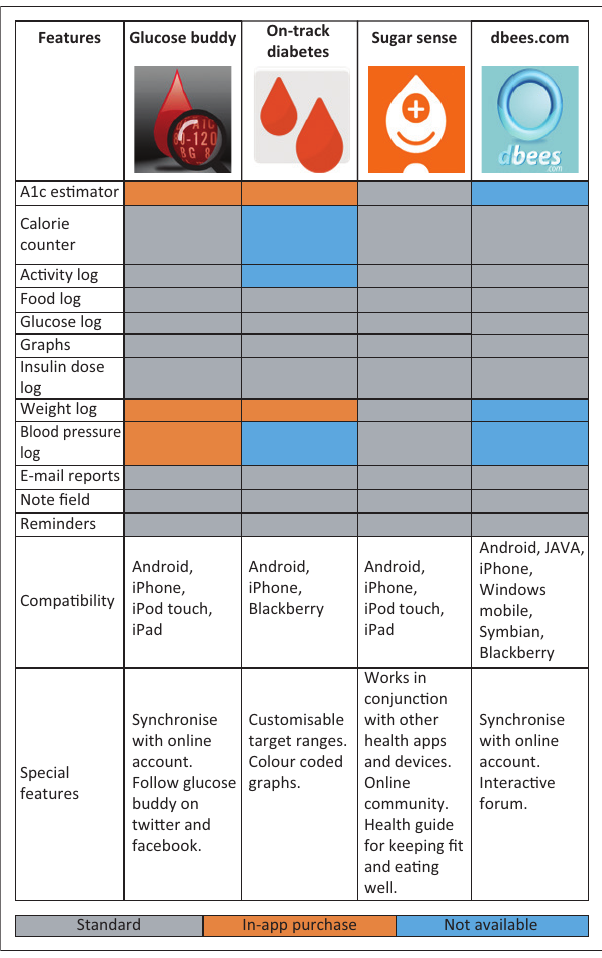
FIGURE 1: Features of the mHealth apps used by the committed